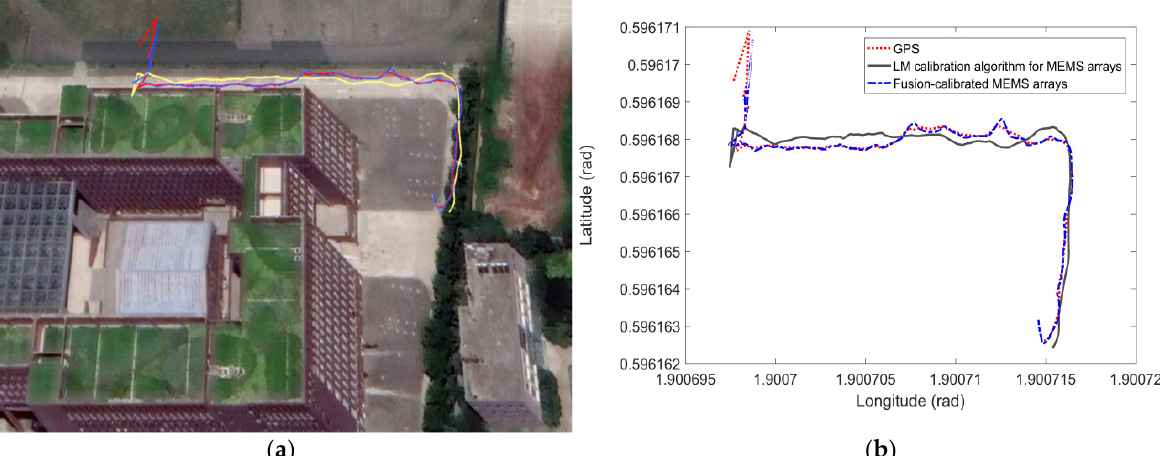
Figure 11. Trajectory in Google Earth 3D map and trajectory solved by MEMS array: ( a ) Actual en- vironmental trajectory; ( b ) Planar trajectory. environmental trajectory; ( b ) Planar